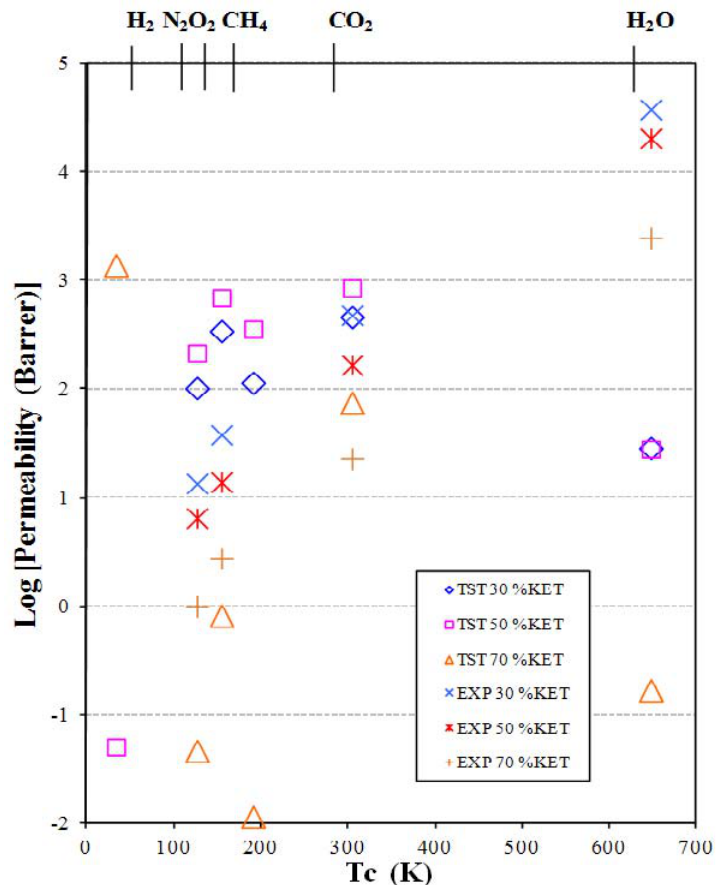
Figure 3. Transition-state theory (TST) calculated and experimental permeability data in modified PEBAX/KET